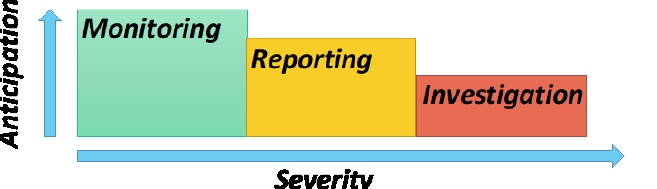
Figure 5. Relationship among monitoring, reporting, and investigation. Authors’ own elaboration based on